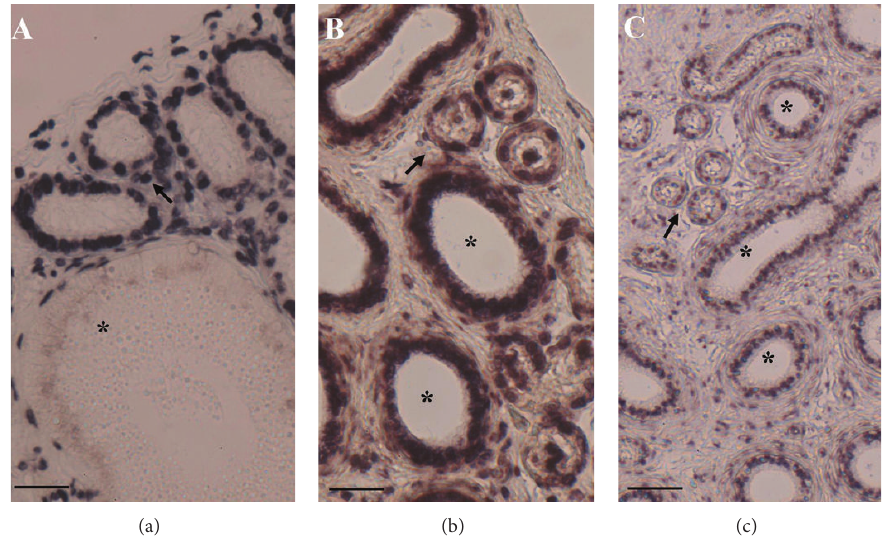
Figure 3: ISH with Er 𝛼 or ER 𝛽 homologous probes on the epididymis. (a) Mating period: Er 𝛼 -mRNA is evident in the epithelium of the efferent ductules ( ↑ ); no expression in the secretory epithelium of the corpus ( ∗ ). Note in the corpus the enlarged lumen ( ∗ ). (b) Winter stasis: the Er 𝛼 expression is evident in the efferent ductules ( ↑ ) and in nonsecreting corpus ( ∗ ). (c) E 2 treated males in mating period: ER 𝛽 -mRNA is expressed in the corpus ( ∗ ) and in the efferent ductules ( ↑ ). Note the restricted empty lumen of the corpus ( ∗ ). The bar is 30 𝜇